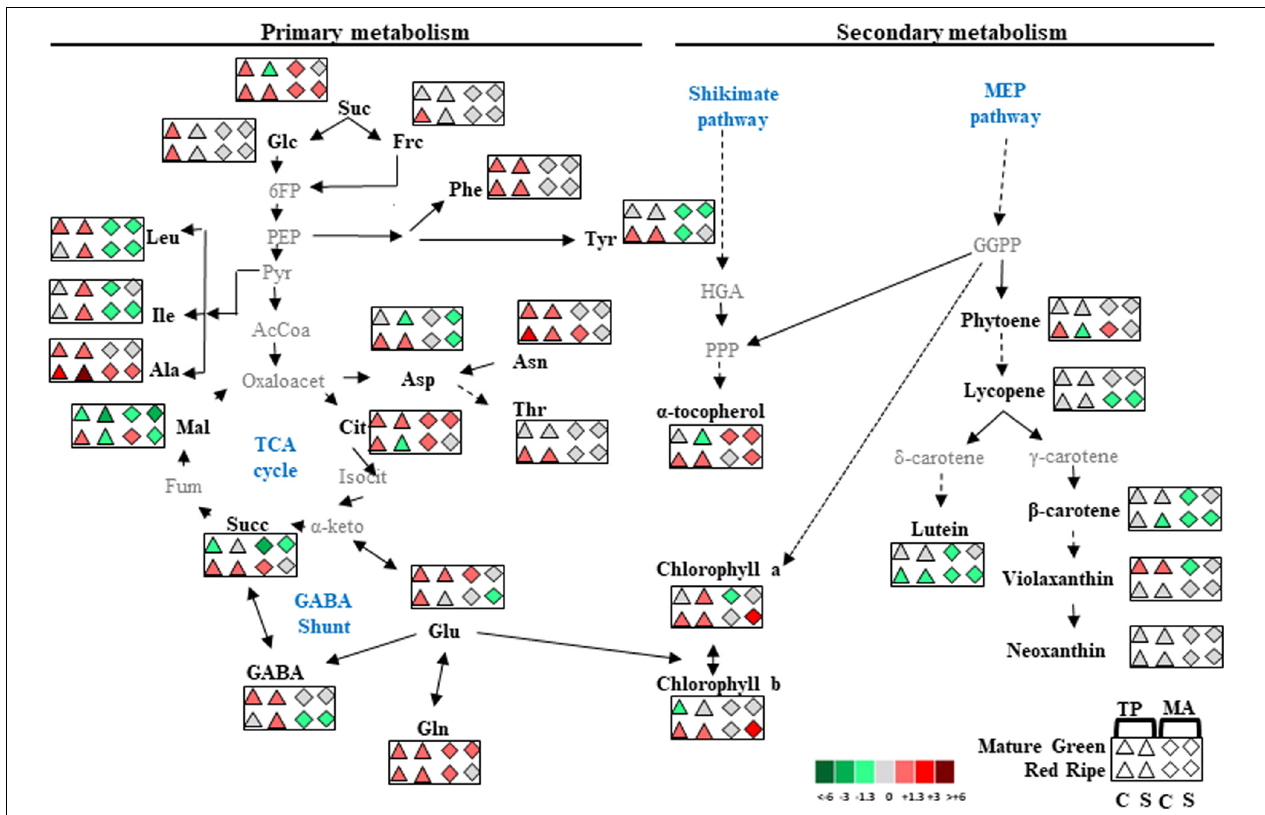
FIGURE 7 | Global overview of metabolic changes occurring in mature green and red ripe fruits of “Tomate Pimiento” (TP) and “Muchamiel Aperado” (MA), from plants grown in control (C) and salt (50 mM NaCl) (S). Data were normalized to “Moneymaker” (MM). Only those metabolites showing upregulation or downregulation in each traditional variety higher 1.3-fold than MM are shown. Color scale is used to display the different amount of metabolite in terms of fold change relative to the level in the appropriate control. Suc, sucrose; Glc, glucose; Fru, fructose; 6FP, fructose-6-phosphate; PEP, phosphoenolpyruvate; Phe, phenylalanine; Tyr, tyrosine; Leu, leucine; Ile, isoleucine; Ala, alanine; Asp, aspartate; Asn, asparagine; Thr, threonine; Pyr, pyruvate; HGA, homogentisic acid; GGPP, geranylgeranyl diphosphate; PPP, phytyl diphosphate; AcCoA, acetyl-CoA; Oxaloacet, oxaloacetate; Cit, citrate; Isocit, isocitrate; α -keto, α -ketoglutarate; Succ, succinate; Fum, fumarate; Mal, malate; Glu, glutamate; Gln, glutamine; GABA, gamma-aminobutyric